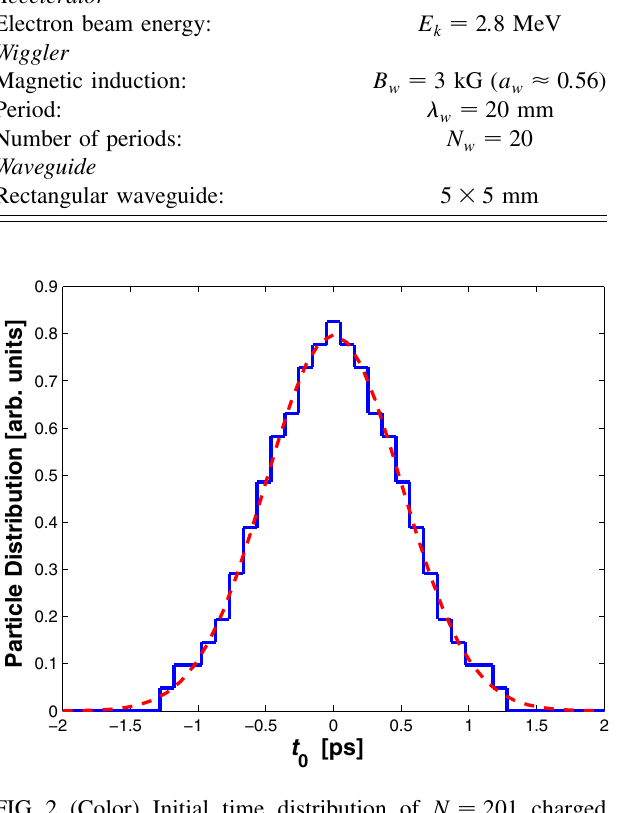
=Q 2 of super- EM